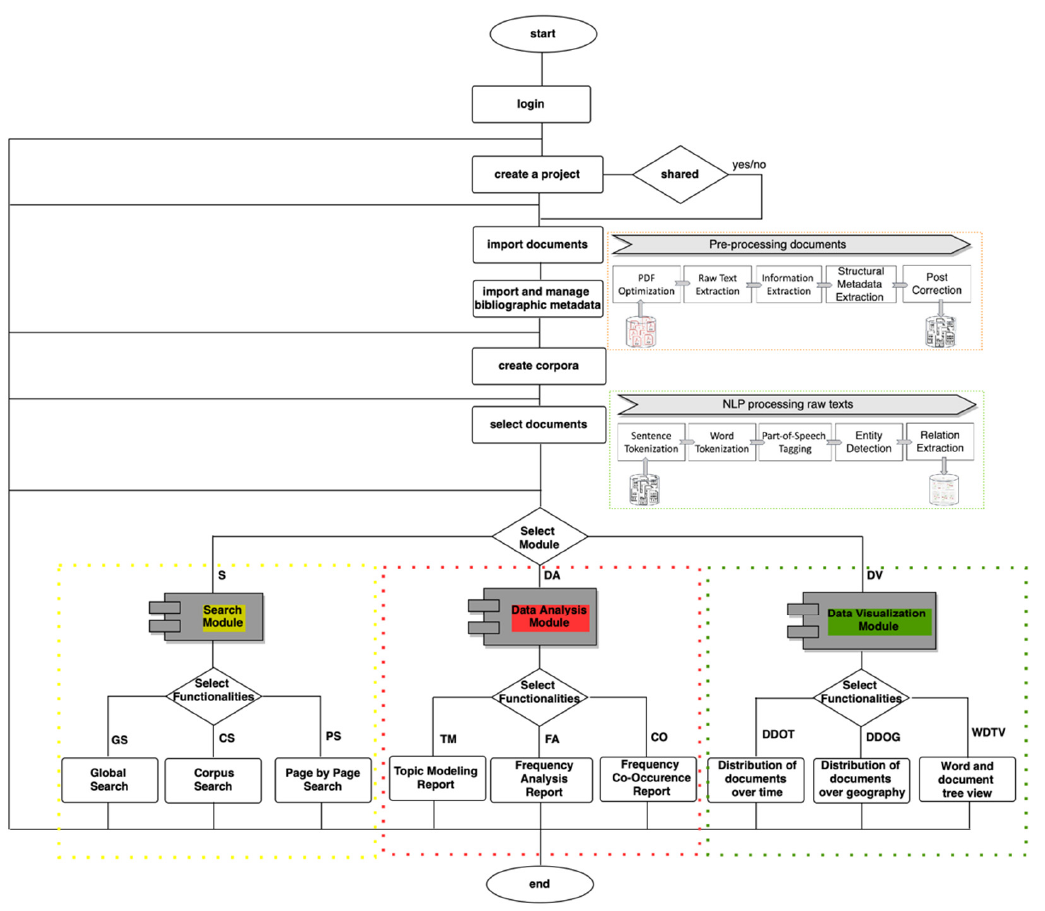
Figure 3. Abstraction of a simplified flowchart and related process flow diagram (light grey) and main module (dark grey) of some use cases to generate reports in the Edumeres Toolbox.